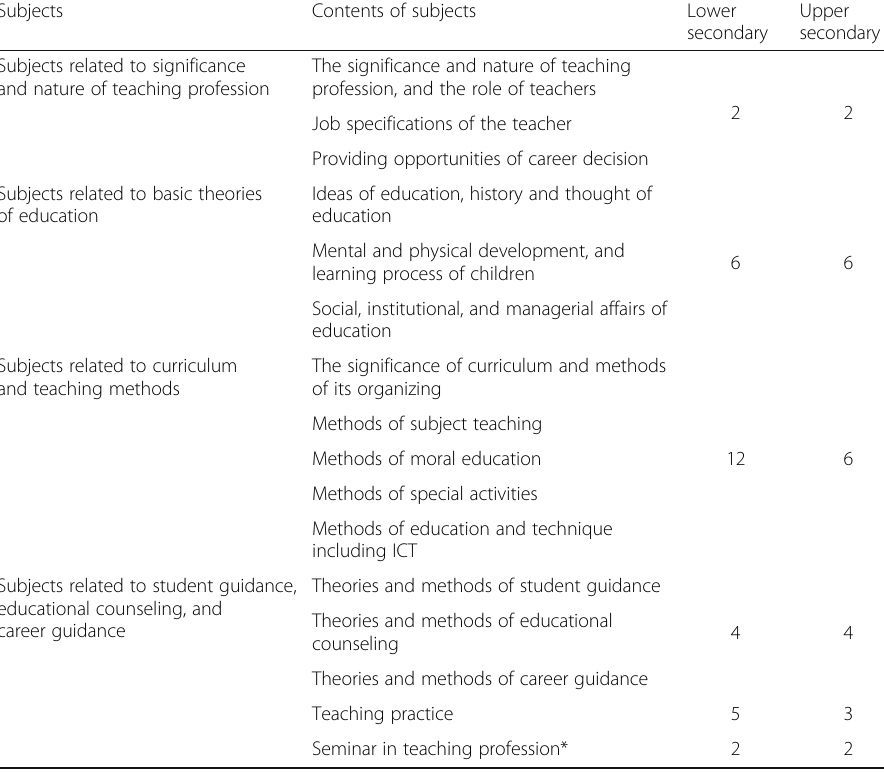
Table 2 The minimum requirement of professional studies since